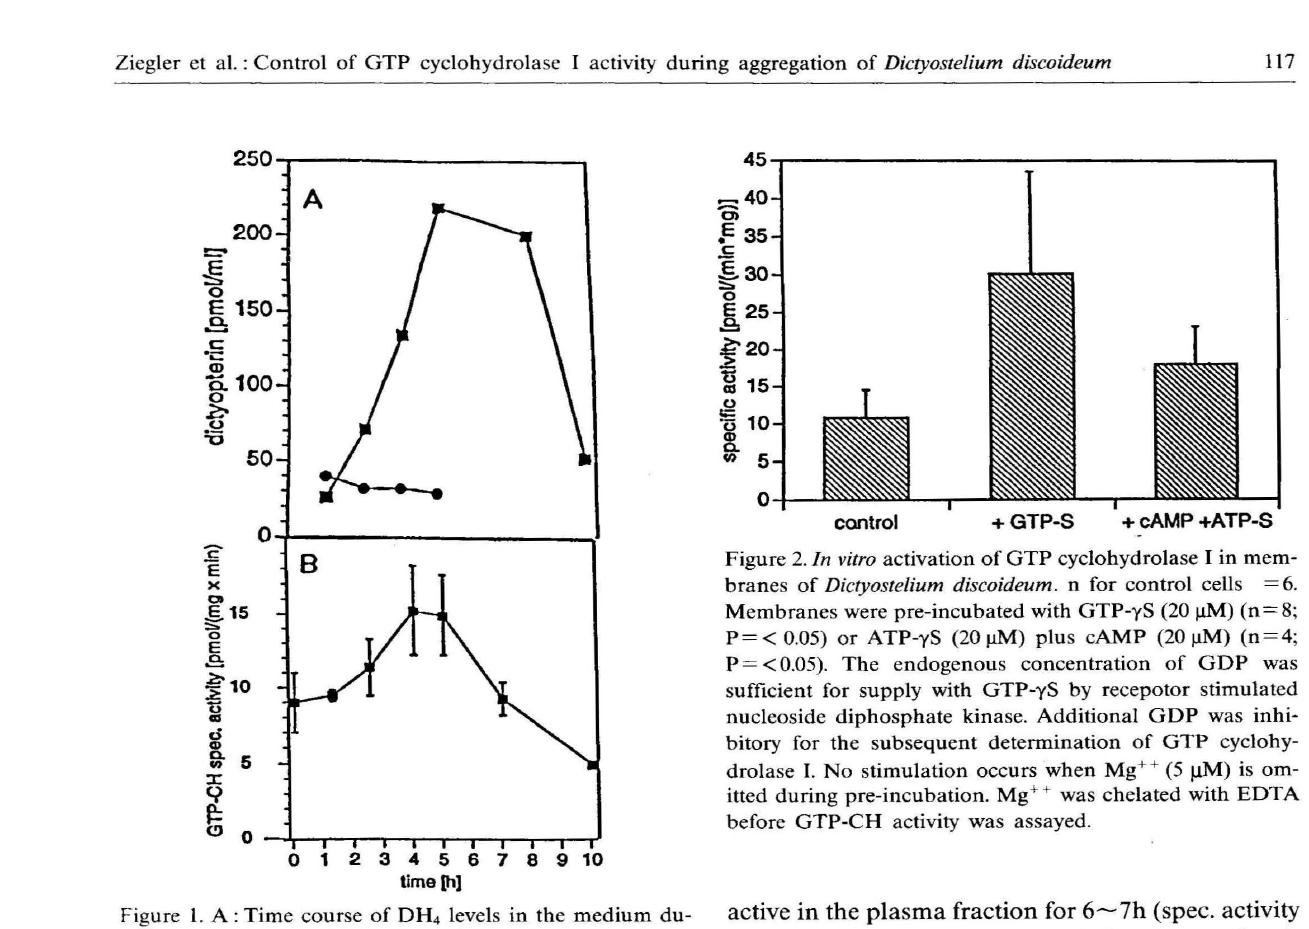
Figure LA : Time course of DH. levels in the medium du :ing starvation induced aggregation of Dictyostelium disco i Jeum. .; Control cells, .; cells cultivated with 2,4-di amino-6-hydroxypyrimidine (3,3 mM). B: Time course of GTP cyclohydrolase I activity in the membrane fraction of Dictyostelium discoideum during starvation induced aggrega tion